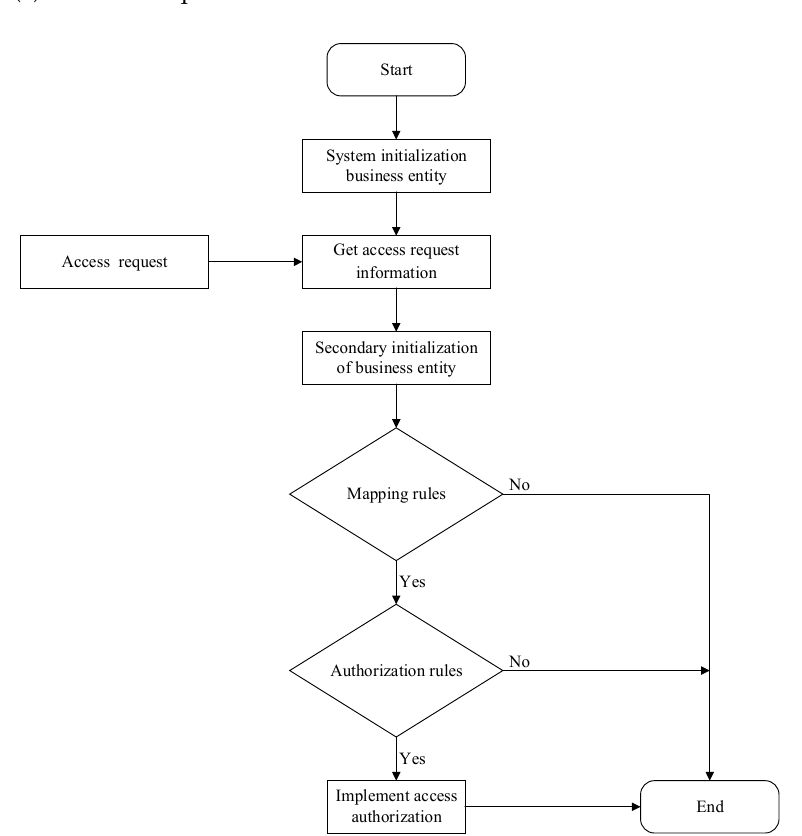
Figure 6. Access-control process, based on business entity.